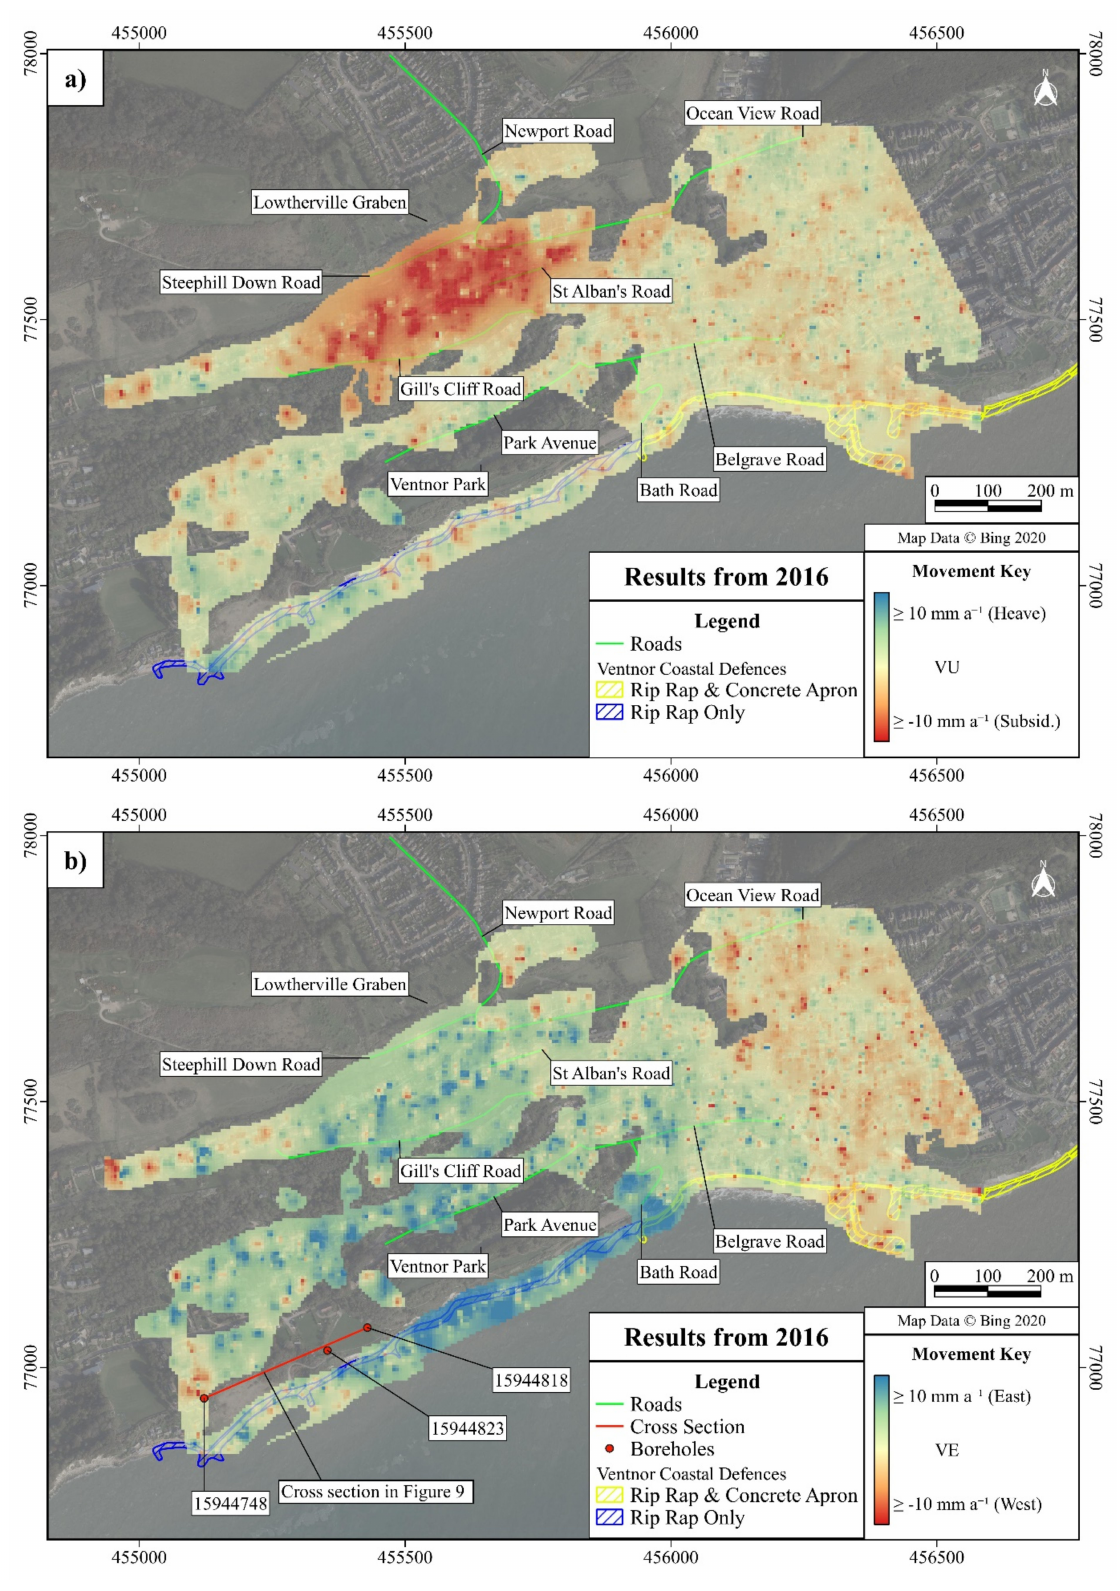
Figure 8. ( a , b ): Vertical velocity (V U ) component ( a ) and horizontal velocity (V E ) component ( b ). Suitable scenes captured during 2016 were used to generate images. Boreholes and approximate cross sections generated in Figure 9 are shown in red on ( b ). Images were created on QGIS with background imagery from Bing Maps